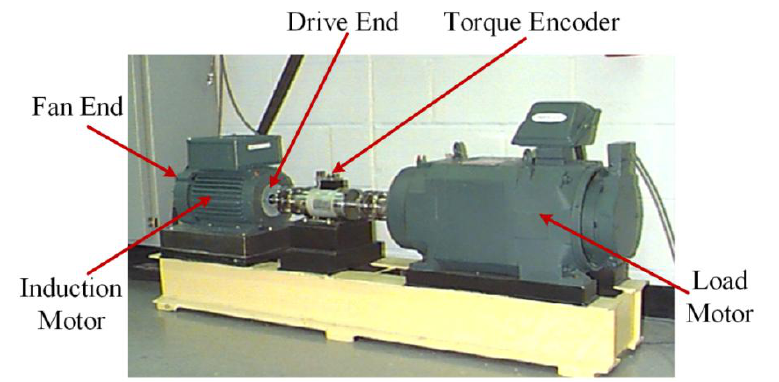
Figure 6. The bearing test stand.